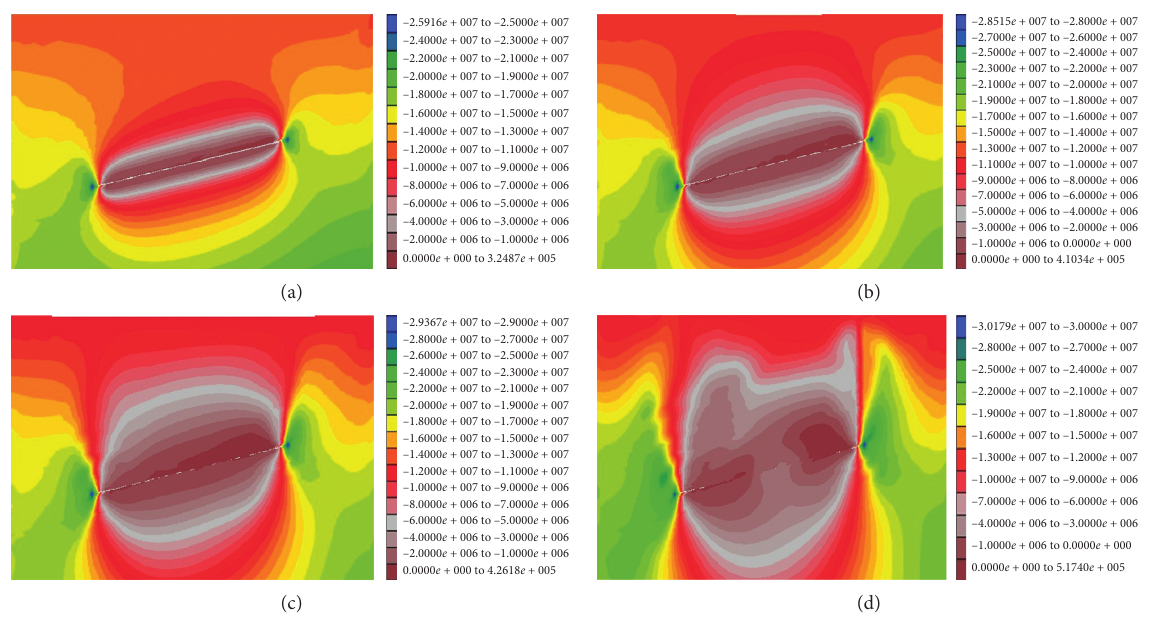
Figure 3: Vertical stress distribution along dip direction at various stages of panel retreat. (a) Vertical stress distribution along dip direction after retreating 40m. (b) Vertical stress distribution along dip direction after retreating 80m. (c) Vertical stress distribution along dip direction after retreating 120 m. (d) Vertical stress distribution along dip direction after retreating 200m.